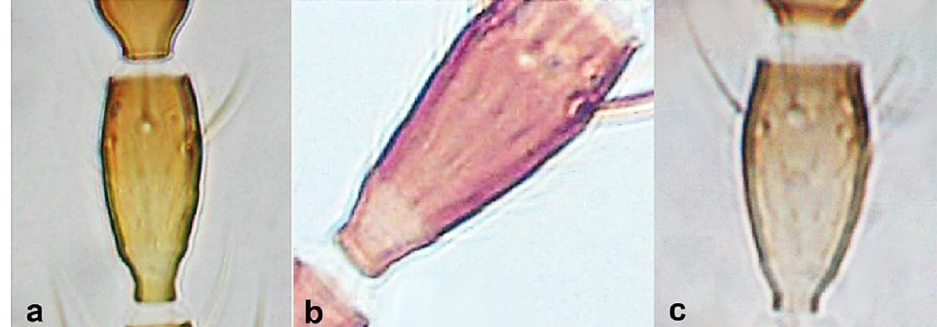
Figure 28. Antennal segment V: ( a ) pale yellow; ( b ) evenly brown; ( c ) bicoloured. 30 Pronotum with five (rarely 4) pairs of prominent postero-marginal setae, with sub- median pair more than twice as long as the discal setae (Figure 29a); male anten- nal segment VI as long as segments IV and V together (Figure 29c); male with a row of around 12 pore plates on each of abdominal sternites II–VII (Figure 29e) ............................................................................................... Pezothrips kellyanus (Bagnall) Pronotum with variable number of prominent postero-marginal setae, usually fewer than five and submedian pair never twice as long as discal setae (Figure 29b); male antennal segment VI shorter than segments IV and V together (Figure 29d); male with only one or no pore plate on each of abdominal sternites II–VII (Figure 29f) ........... 31